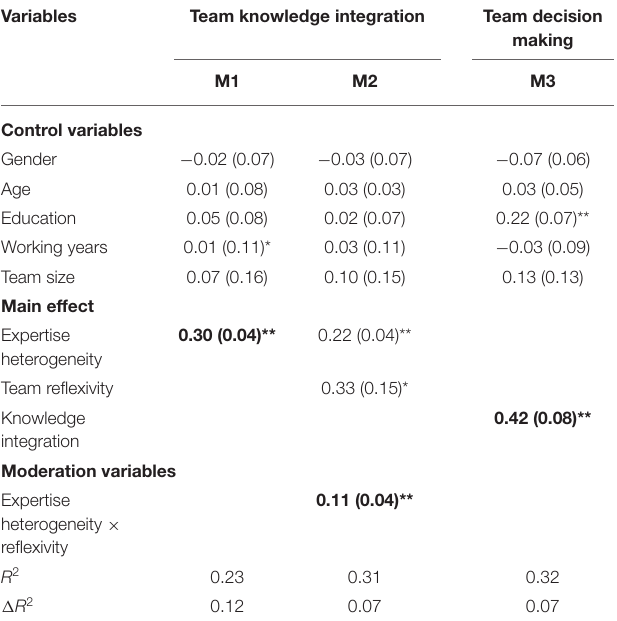
TABLE 3 | Regression analysis.